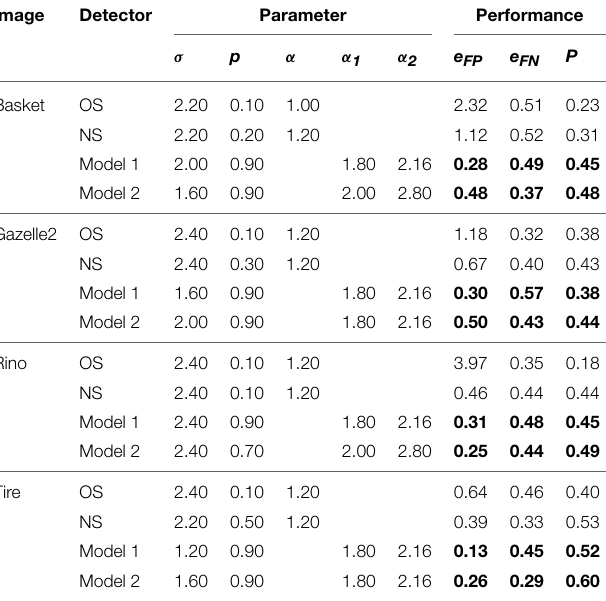
Bold values indicate the performance of our models.